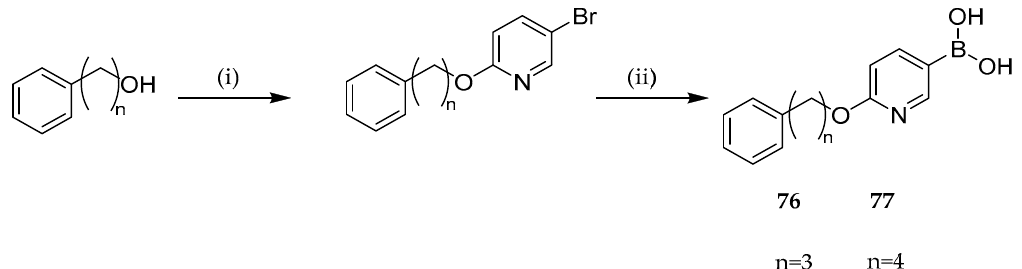
Scheme 17. Synthesis of NorA efflux pump boronic acid inhibitors compounds 76 and 77 . Reaction conditions: ( i ) (1) NaH, anhydrous THF, 0 °C to r.t., 30 min then reflux, 1 h; (2) 5 ‐ bromo ‐ 2